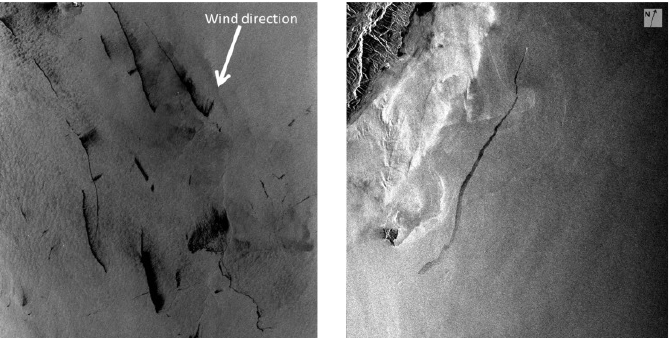
Figure 1. SAR image obtained by the European Remote Sensing satellite ERS-2 on April 1997 over the South China Sea (left image) and SAR image obtained by the ERS-1 satellite on May 1994 over Pacific Ocean east of Taiwan (right image). These images (area: 100 km × 100 km) showing an oil spill